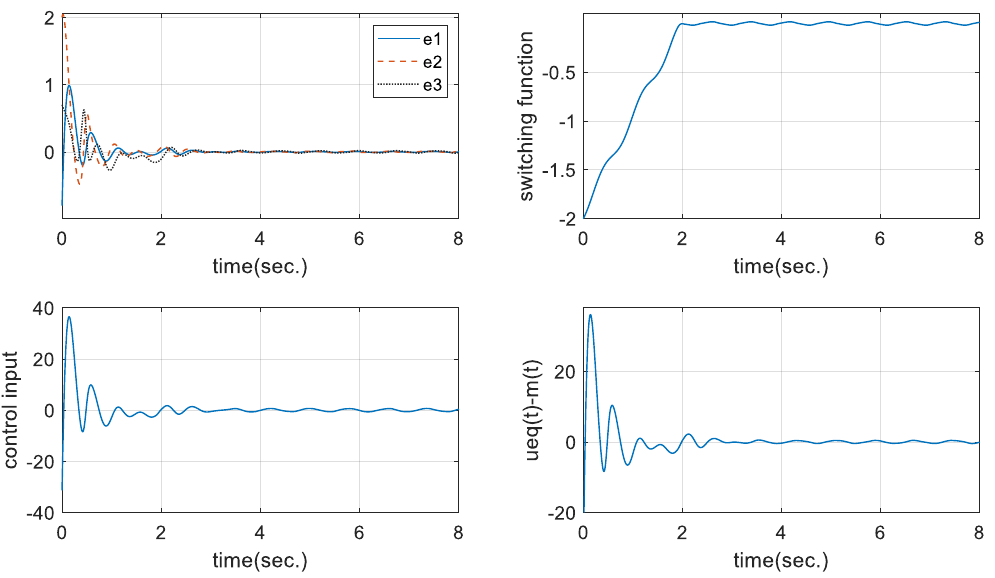
Figure 6. Controlled system responses with continuous equivalen SMC.